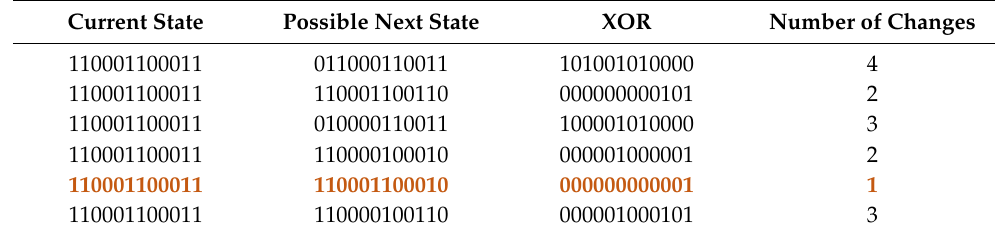
Table 3. Calculation of the transition from the current state of transistors to a possible version of the next voltage vector in a sequence in search of the smallest switching number.